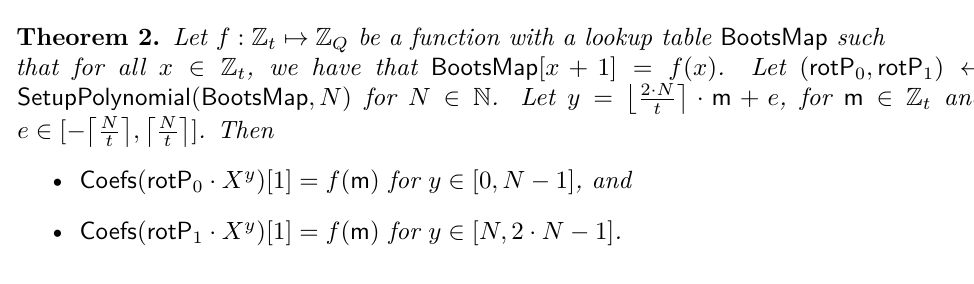
Figure 3: Algorithm to set up the rotation polynomial based on a look up